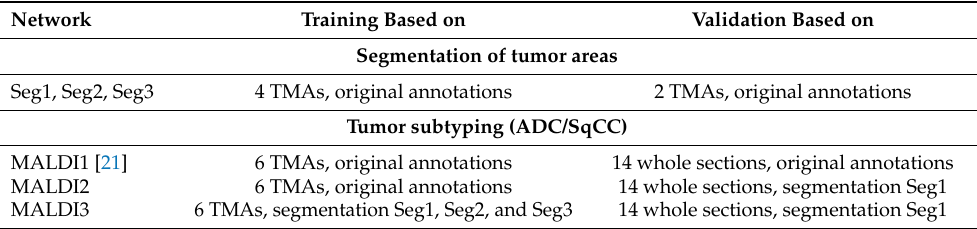
Table 1. Overview of networks trained for tumor segmentation and subtyping (ADC/SqCC), and their respective training and validation datasets. TMAs: tissue micro